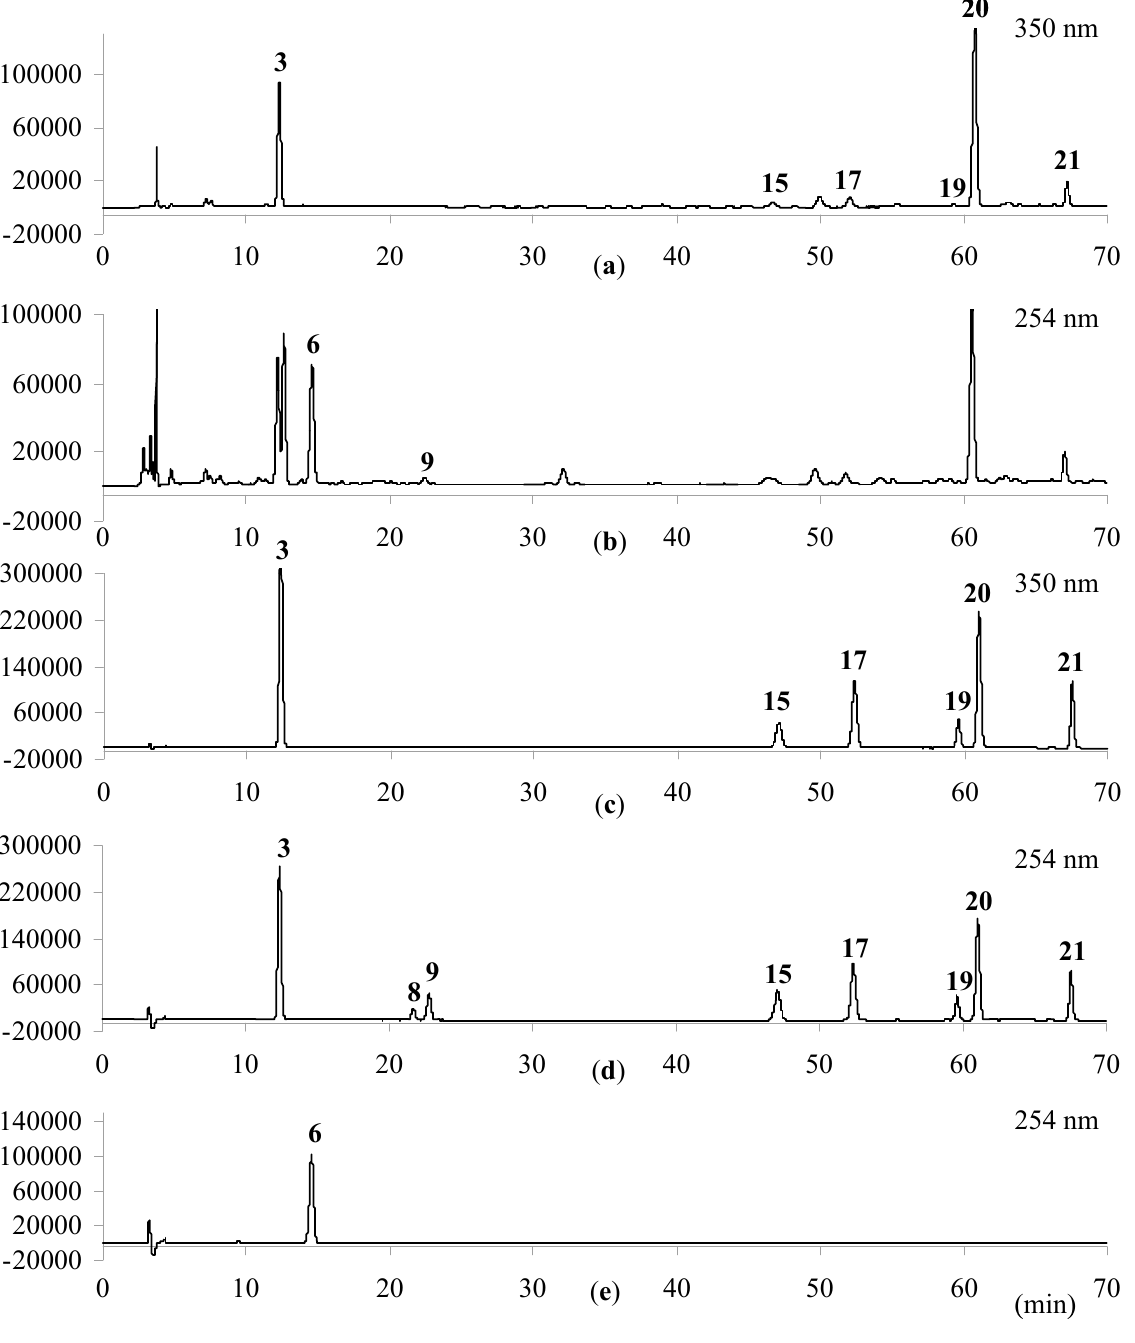
Figure 3. HPLC chromatograms of LJF samples collected in Jiangsu province ( a , b ) and mixed reference substances ( c – e ). (a) samples detected at 350 nm; (b) samples detected